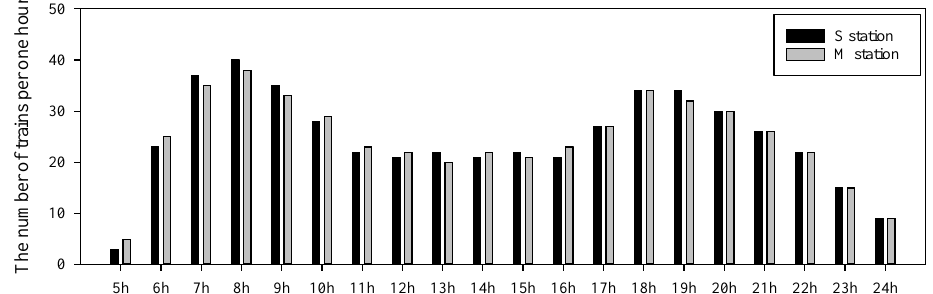
Figure 2. Number of trains at the M station and S station on weekdays.